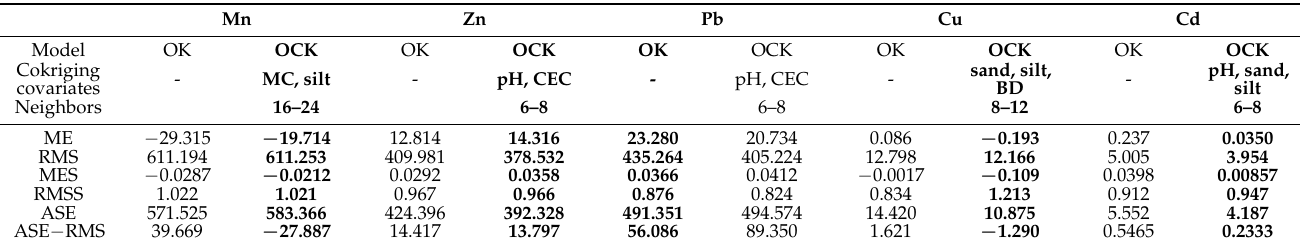
Table 3. Ordinary kriging (OK) and ordinary cokriging (OCK) diagnostics from interpolation models for five metals. The better model is in bold